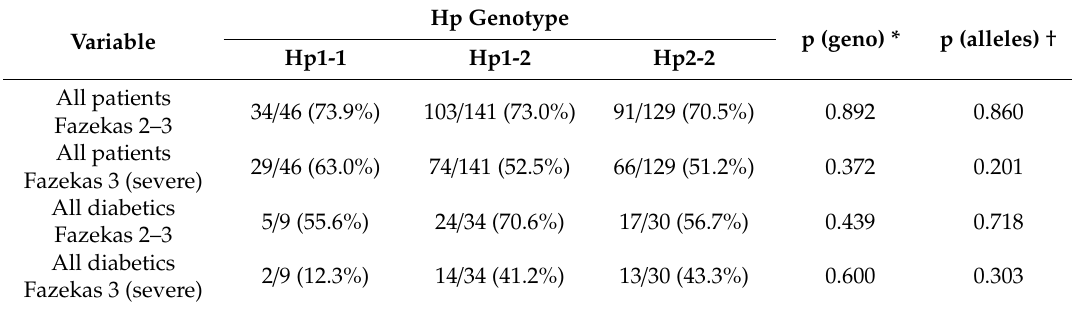
Table 3. White matter lesions in the Helsinki Stroke Aging Memory Study (SAM) patients.